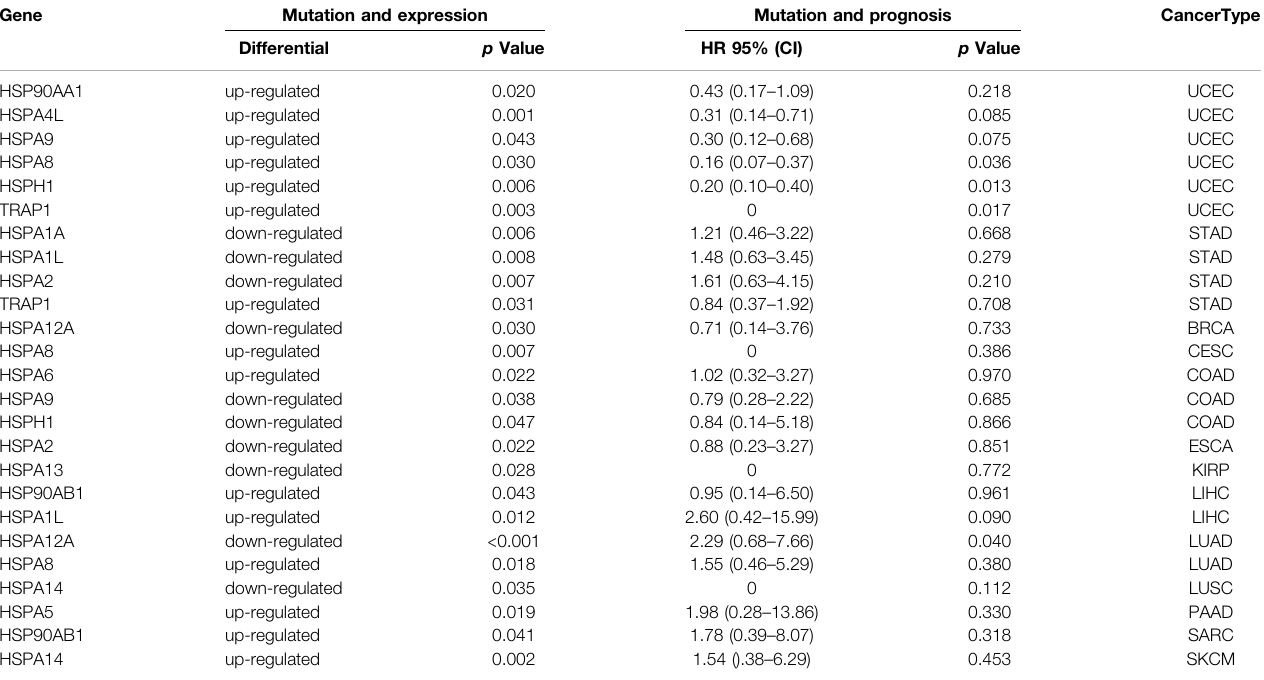
TABLE 4 | The correlation of HSPs mutations with expression and prognosis in pan-cancer. Gene Mutation and expression Mutation and prognosis